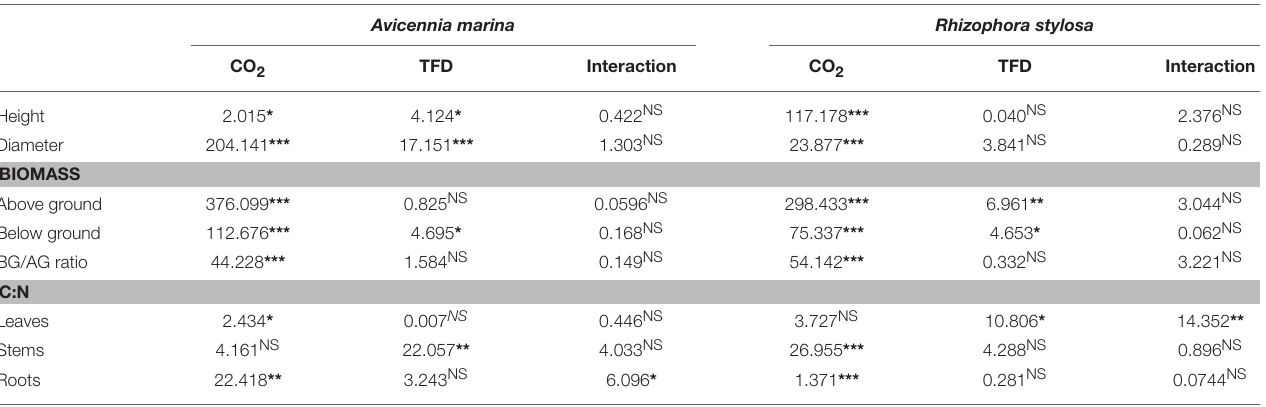
FIGURE 2 | Changes in basal stem diameters and heights of A. marina (A,C) and R. stylosa (B,D) grown in ambient (closed symbols) and elevated (open symbols) CO 2 , and two lengths of tidal flooding: normal (solid lines) and longer (dotted lines). Values are means ± SEM ( A. marina n = 125; R. stylosa n = 180). TABLE 1 | Significance values reported after a Linear Mixed-Effects